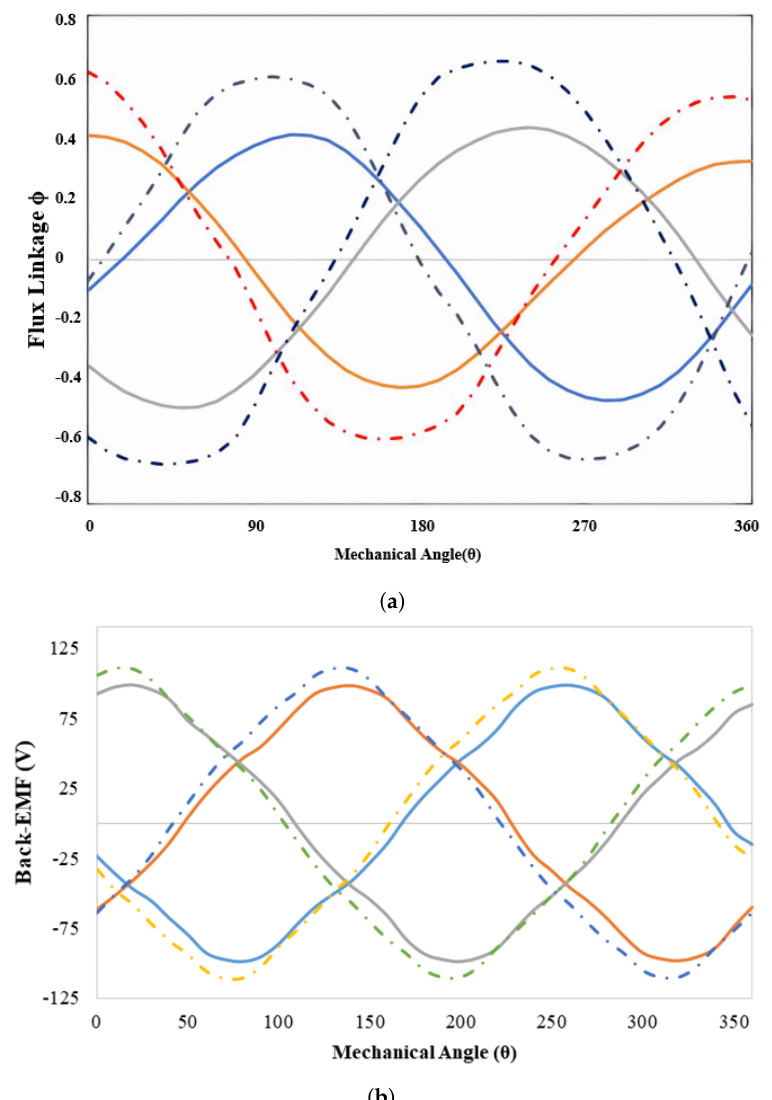
Figure 19. ( a ) Comparison between initial and optimized ϕ p − p ( b ) back-EMF.